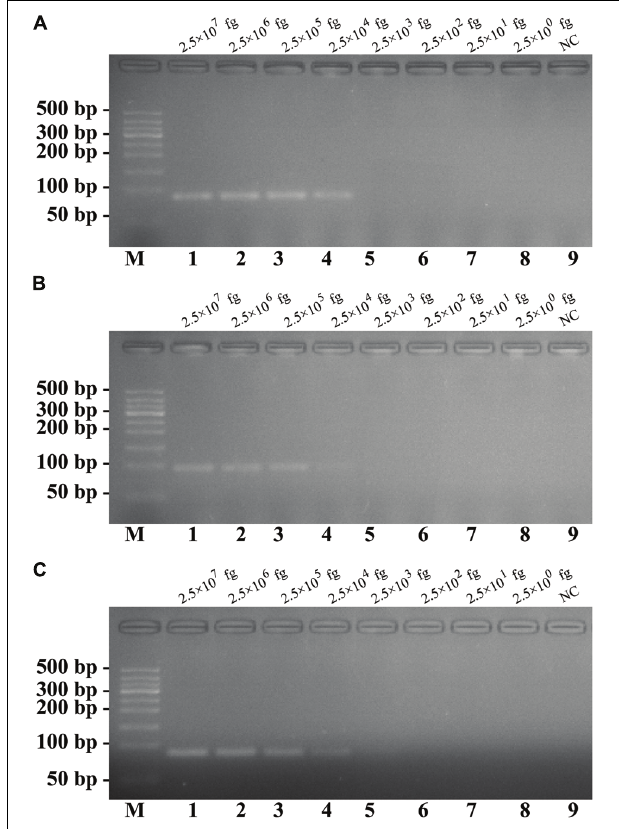
FIGURE 6 | The analytical sensitivity of conventional PCR assay for detecting a single target. Three sets of conventional PCR primer targeting ply , nuc, and Ef0027 genes were in different reactions: S. pneumoniae (A) , S. aureus (B) , and E. faecalis (C) . Agarose gel electrophoresis was applied to monitor the traditional PCR products; lane M, DL 50-bp DNA markers, lanes 1–8, the genomic DNA levels of 2.5 × 10 7 , 2.5 × 10 6 , 2.5 × 10 5 , 2.5 × 10 4 , 2.5 × 10 3 , 2.5 × 10 2 , 2.5 × 10 1 , and 2.5 × 10 0 fg per reaction; lane 9, NC (negative control). The DNA levels from 2.5 × 10 7 to 2.5 × 10 4 fg per tube provide the positive signals, 2.5 × 10 3 and 2.5 × 10 0 fg per reaction and negative control generate negative signal.